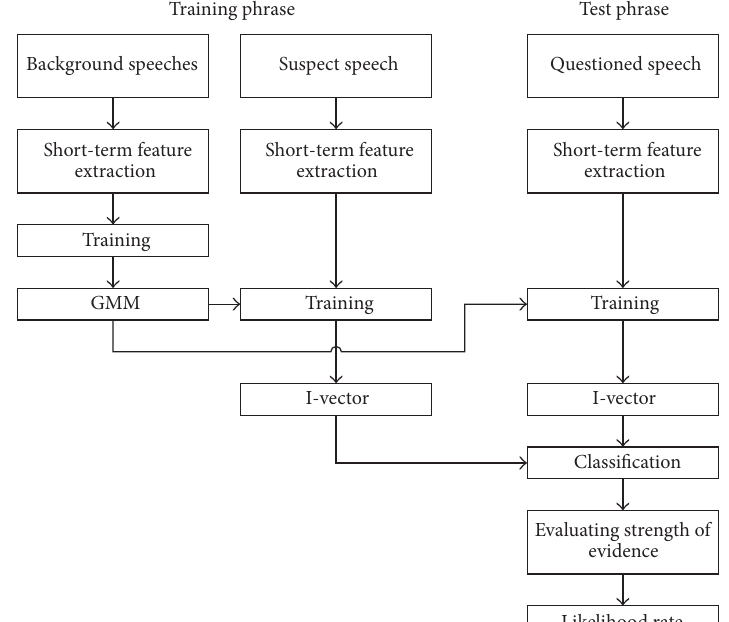
Figure 1: Forensic speaker recognition